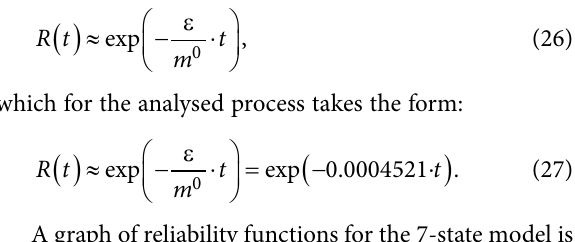
Table 9. Values of coefficient e i Table 10. Average times 0